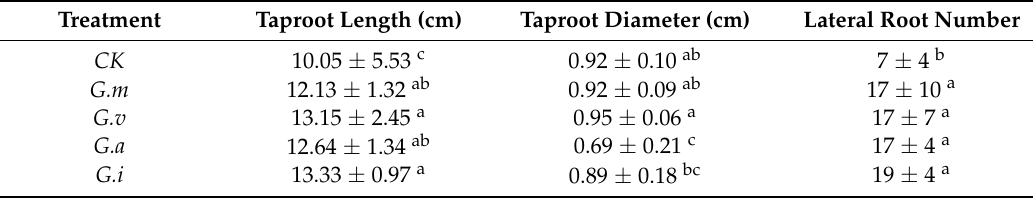
Table 3. Effect of AMFs inoculation on root traits of S. miltiorrhiza seedlings.